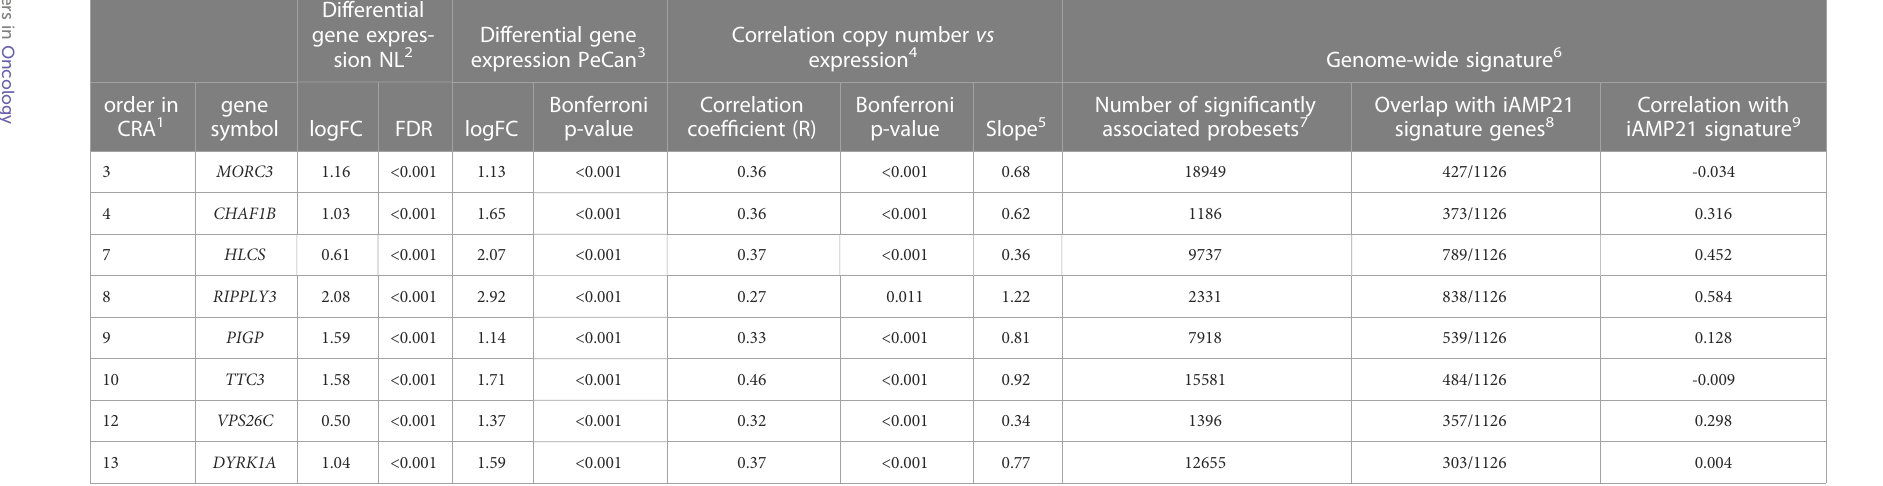
1 Order in which genes are located in the combined CRA, from centromere to telomere. Numbers indicate the order considering all 13 genes. 2 Comparing 12 iAMP21 versus 143 B-other samples using limma. All expression probesets on the Affymetrix U133 Plus 2 array were tested and false discovery rate was used for multiple testing correction. 3 Comparing 17 iAMP21 samples with 174 B-other samples. FPKM expression values were extracted from the PeCan database. Differential expression was tested for the CRA genes using Mann Whitney U test and Bonferroni corrected. 4 Spearman correlation of copy number with gene expression within each gene, using all 155 NL samples (B-other plus iAMP21). 5 Slope of linear regression trendline using all 155 NL samples. 6 Gene-set testing by Globaltest, which tests the association of gene expression of the indicated gene with genome-wide gene expression using 155 NL samples (not including iAMP21 status). 7 Number of probesets signi fi cantly correlated with the expression of the CRA gene. 8 Overlap between non-supervised genome-wide expression changes for the CRA gene and the iAMP21 limma signature (1126 probesets), showing number of probesets that signi fi cantly overlap with the iAMP21 signature. 9 Spearman correlation coef fi cient (R) of -log10(FDR) in limma with local -log10(FDR) in Globaltest of all probesets. CRA, common region of ampli fi cation; logFC, log 2 fold change; FDR, false discovery